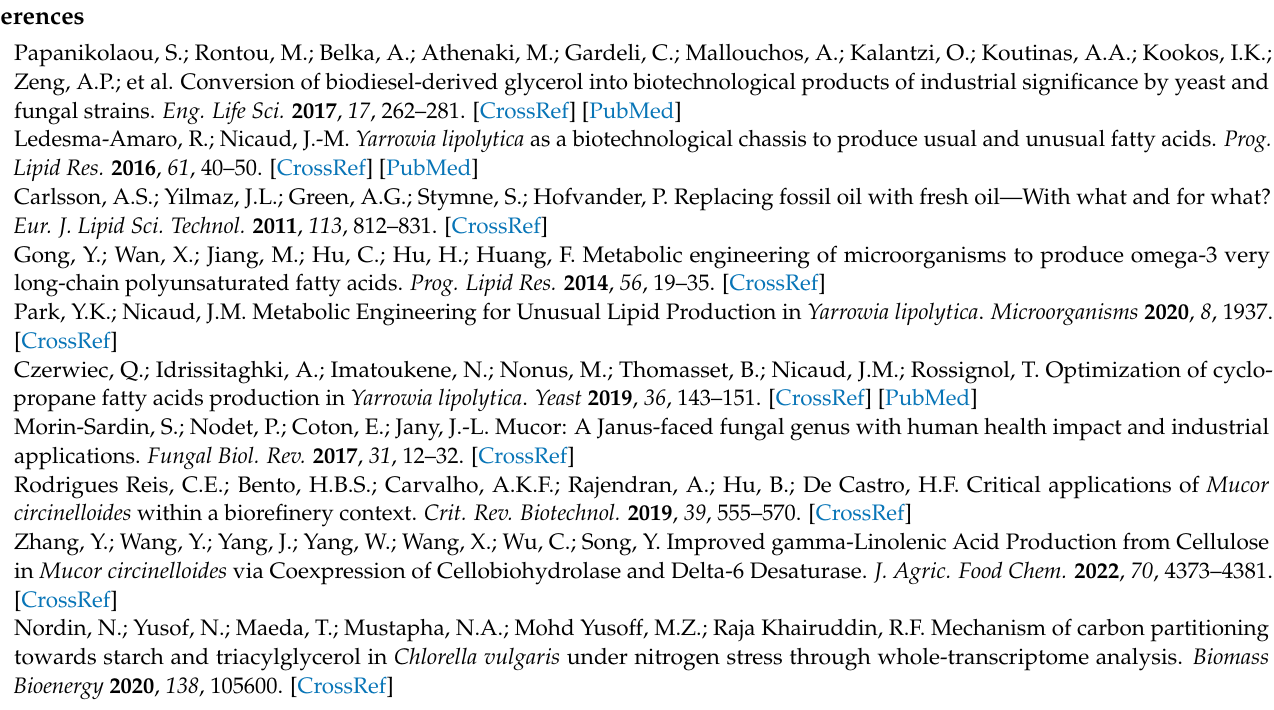
Table S2: Cell growth rate of mutants and the control